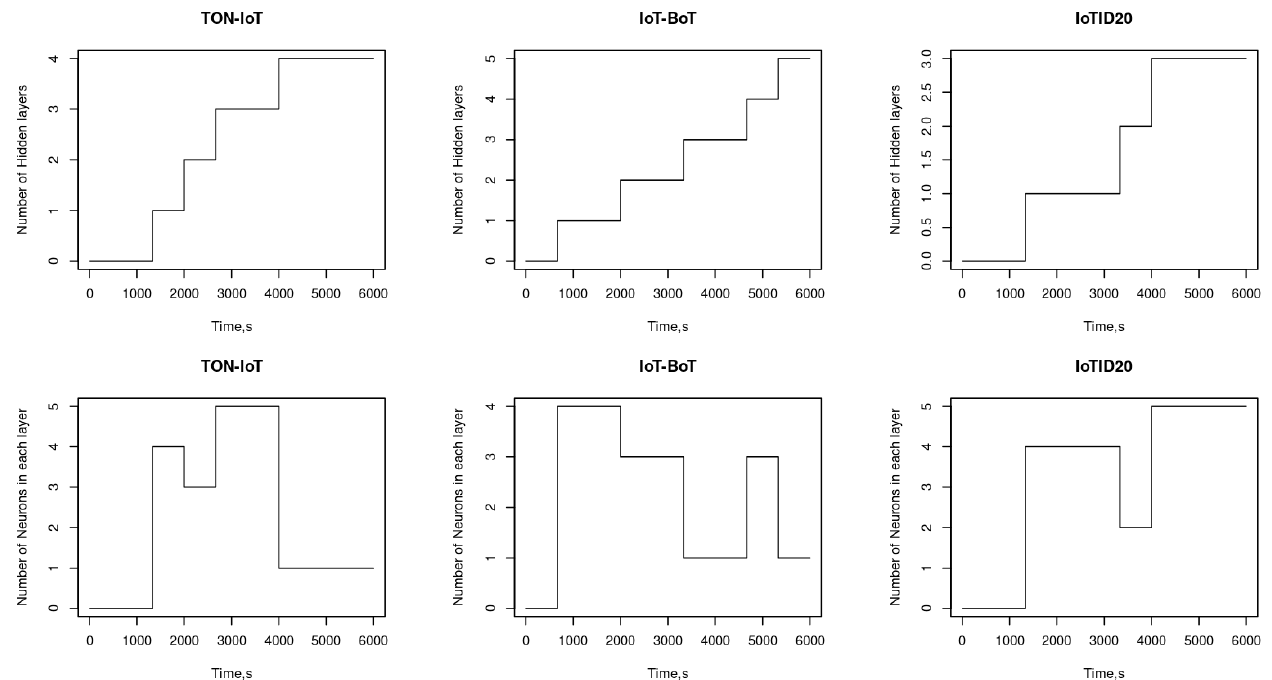
Figure 5. Evolving of SEHIDS for BoT-IoT, IoTID20 and